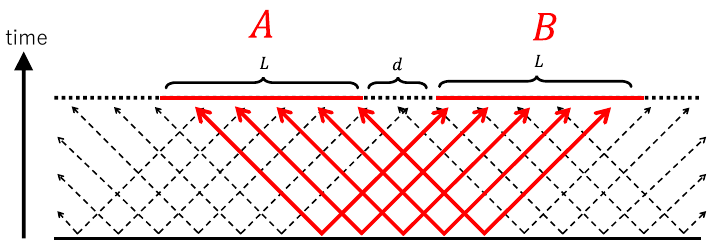
Figure 1 . The setup we consider in the present paper. The arrows show the quasi-particle picture of the information spreading under the global quench.